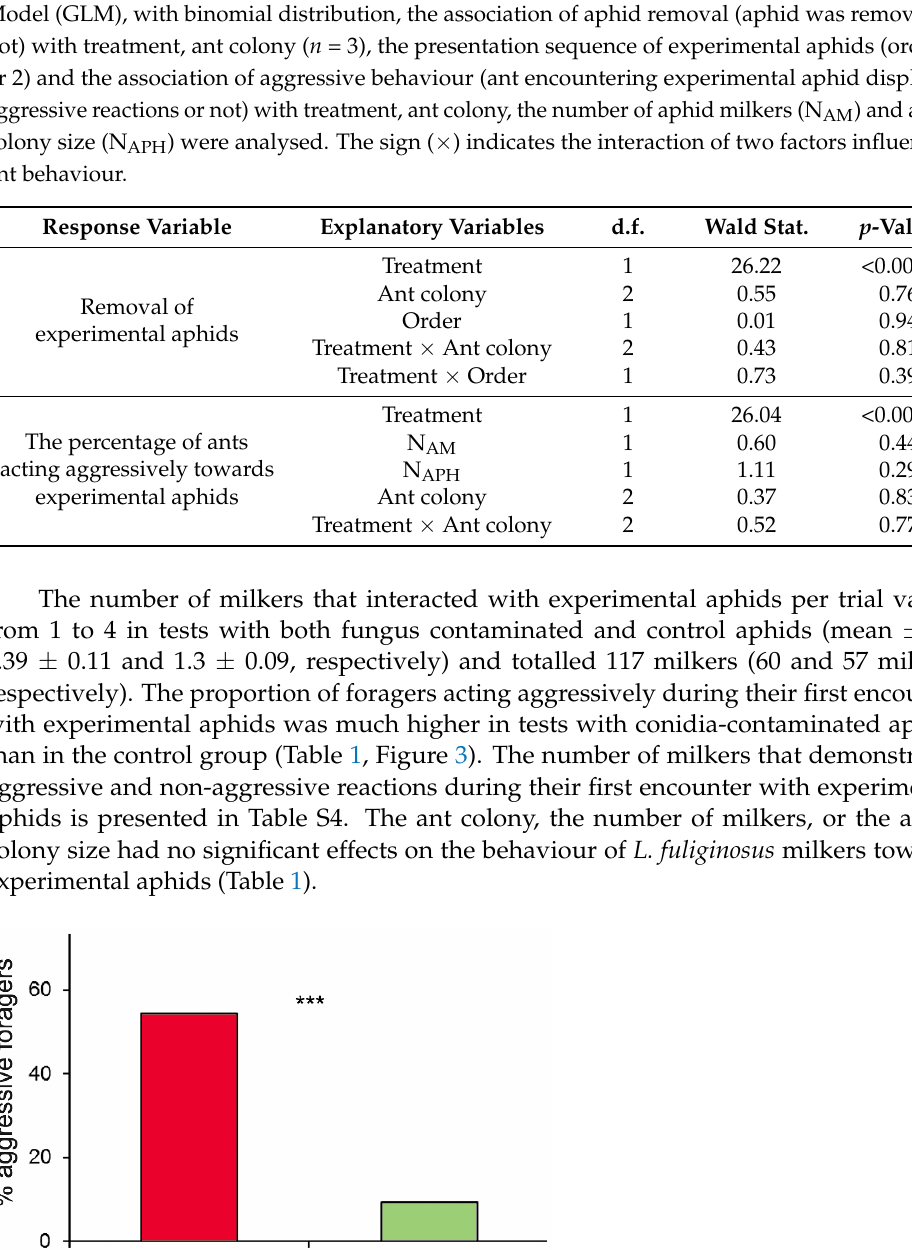
Table 1. Statistical analysis of the behaviour of Lasius fuliginosus milkers towards Chaitophorus populeti experimental aphids contaminated with Beauveria bassiana (BB) or not (C). With a Generalized Linear Model (GLM), with binomial distribution, the association of aphid removal (aphid was removed or not) with treatment, ant colony ( n = 3), the presentation sequence of experimental aphids (order: 1 or 2) and the association of aggressive behaviour (ant encountering experimental aphid displayed aggressive reactions or not) with treatment, ant colony, the number of aphid milkers (N AM ) and aphid colony size (N APH ) were analysed. The sign ( × ) indicates the interaction of two factors influencing ant behaviour.